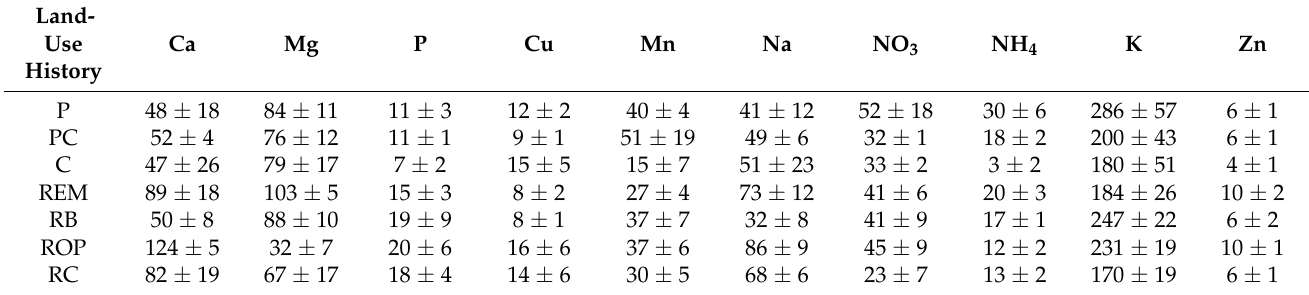
Table 5. Means and S.E.M.s of soil nutrients (ppm) for land-use histories in 2018. Land-use histories are cow pasture (P), cow pasture converted from row crop (PC), row crop fields (C), remnant prairie (REM), bison prairie restored from P and PC pastures (RB), prairie restored from old pasture (ROP), and prairie restored from row crop (RC).